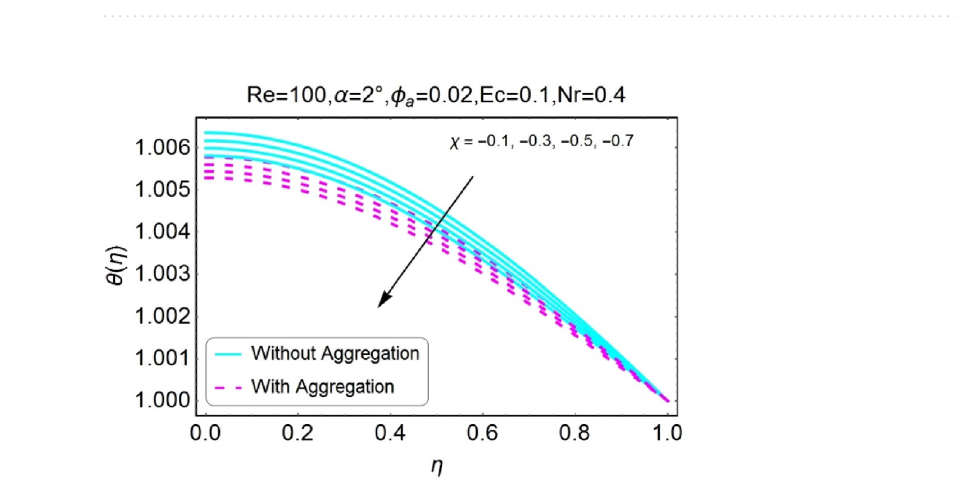
Figure 20. χ varying θ for shrinking walls (divergent channel).